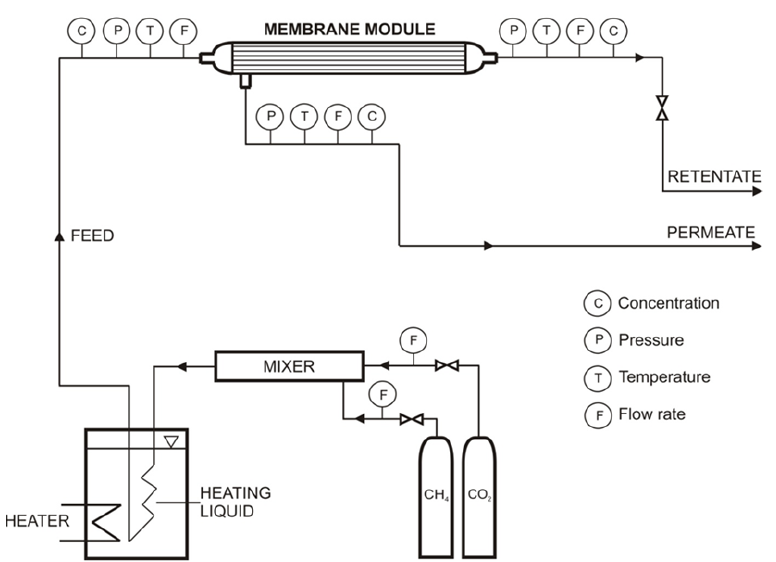
Figure 1. Experimental setup for gas permeation studies.